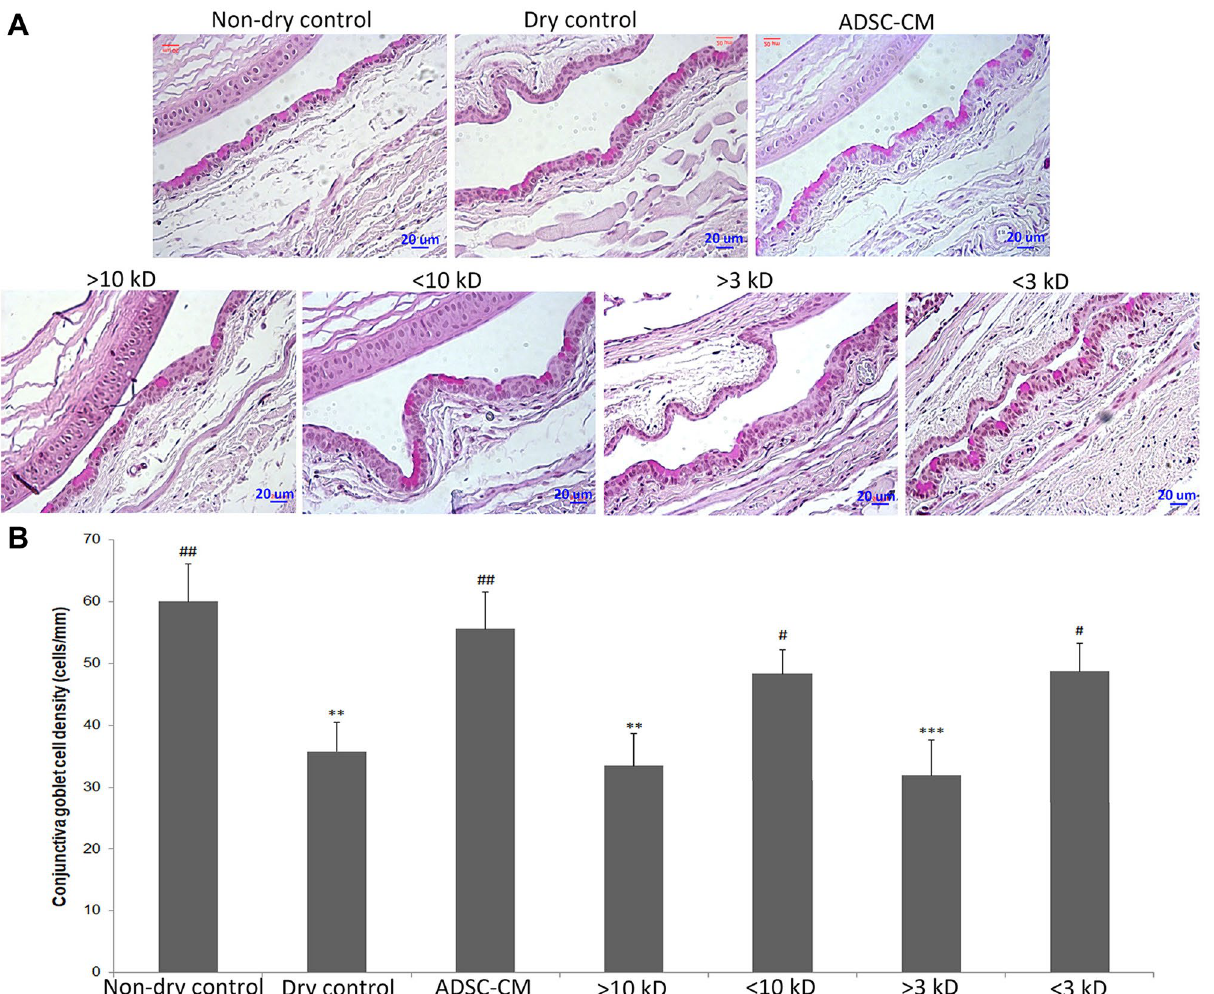
Figure 5. The conjunctival goblet cell density of the BALB/c mice in the controlled-environment chamber (CEC)-induced dry eye model. (A) The conjunctival goblet cells demonstrated by Periodic acid-Schiff stain were reduced in the controlled-environment chamber (CEC)-induced dry eye. Mice treated with ADSC-CM, fractions of < 10 kD, or < 3 kD, had higher goblet cell densities than those treated with > 10 kD and > 3 kD. The analytical data of the above were presented in (B). Data were in means ± SD. *p < 0.01, compared with Non-dry control. #p < 0.05, ##p < 0.01 compared with Dry control. (N =